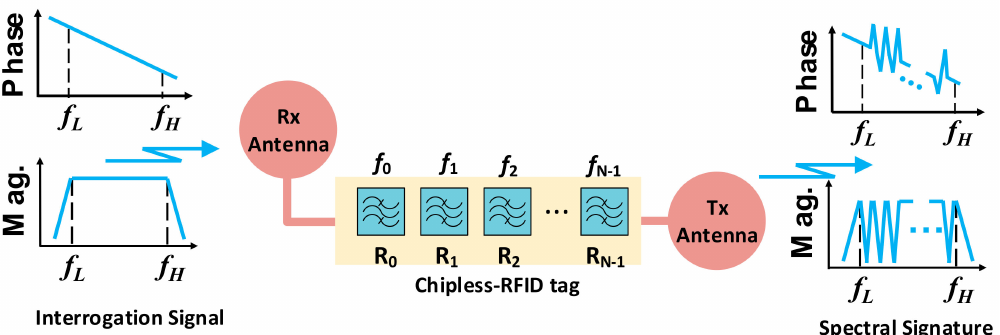
Figure 15. The working principle of retransmission frequency domain chipless-RFID systems.